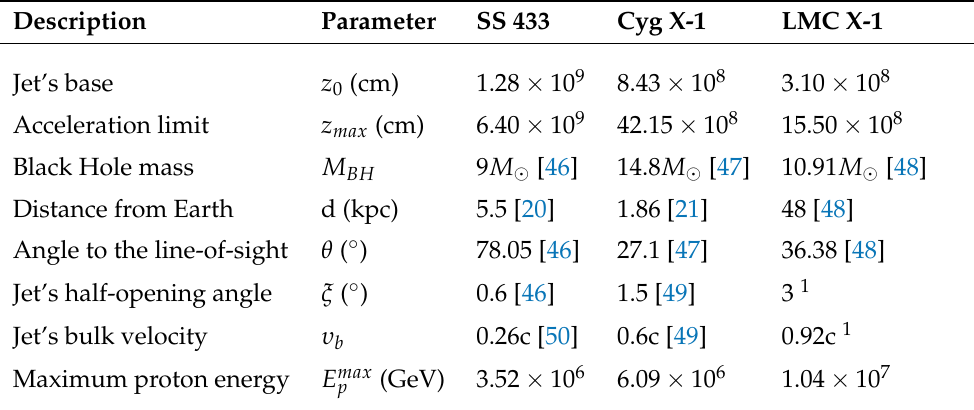
Table 1. Parameters describing geometric characteristics of the well-studied SS 433, Cygnus X-1 and the extragalactic LMC X-1 binary